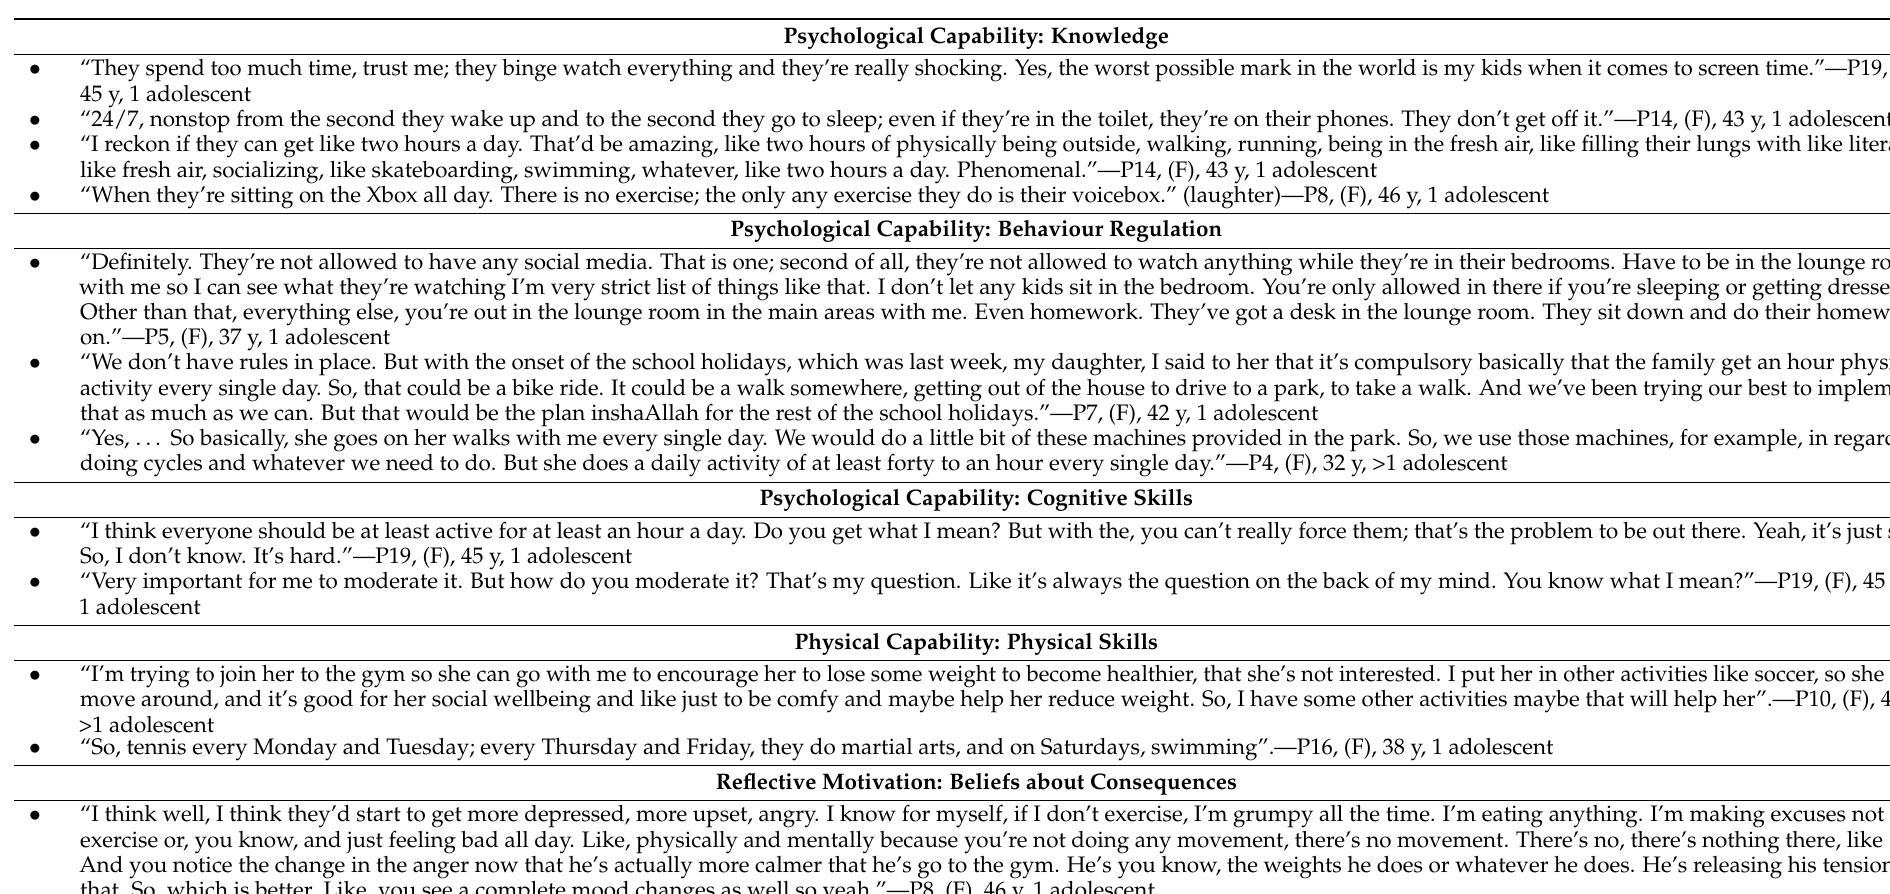
Table 3. Representative quotes from parents by key